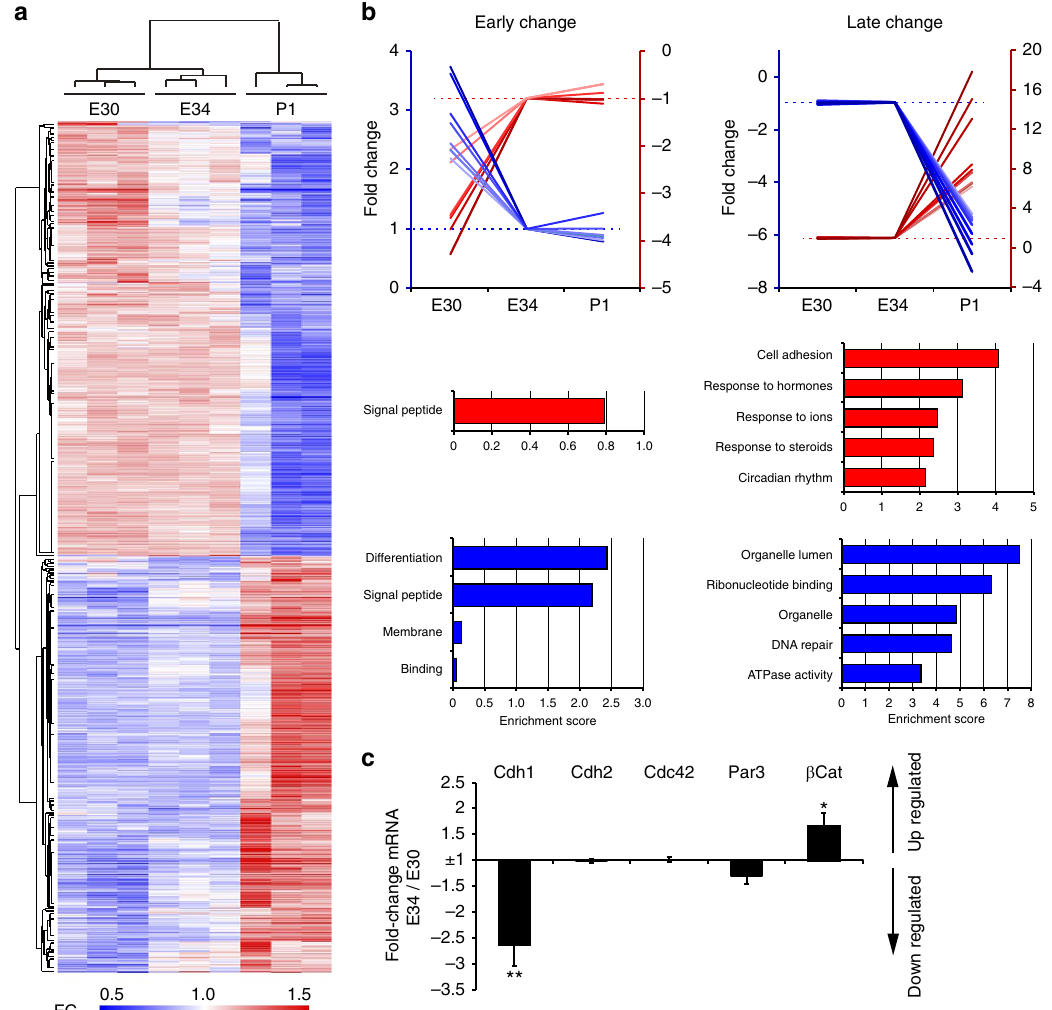
Figure 5 | Differential gene expression in VZ across developmental stages. ( a ) Heatmap of unsupervised hierarchical clustering of gene probes differentially expressed in VZ between E30, E34 and P1 (FC, fold change), and dendrogram of similarity between samples. Each lane is a biological replica. The vast majority of probes were differentially expressed between E34 and P1, but not between embryonic stages. ( b ) Examples of developmental expression profiles of differentially expressed genes, and for each profile the functional gene annotation terms as analysed and clustered using DAVID. The five clusters with the highest enrichment scores for up- and downregulated genes are shown. The vast majority of DEGs (FC 4 2, P o 0.05) had ‘late-change’ profile (increase, red axis; decrease, blue axis; only 10 genes with highest FC in each axis are plotted), whereas much fewer had ‘early’ change profiles (41 probes). Red axes are for data represented in red, and blue axes for data in blue. ( c ) Quantitative RT–PCR data for candidate gene expression levels in VZ, expressed as FC between E34 and E30 (mean values ± s.e.m.). Negative values indicate lower expression at E34 and positive values indicate higher expression at E34. Cdh1 expression decreased 4 2.5-fold between these two ages, whereas b Cat increased 1.6-fold and other apical complex protein genes remained unchanged. * P o 0.05, ** P o 0.01, t